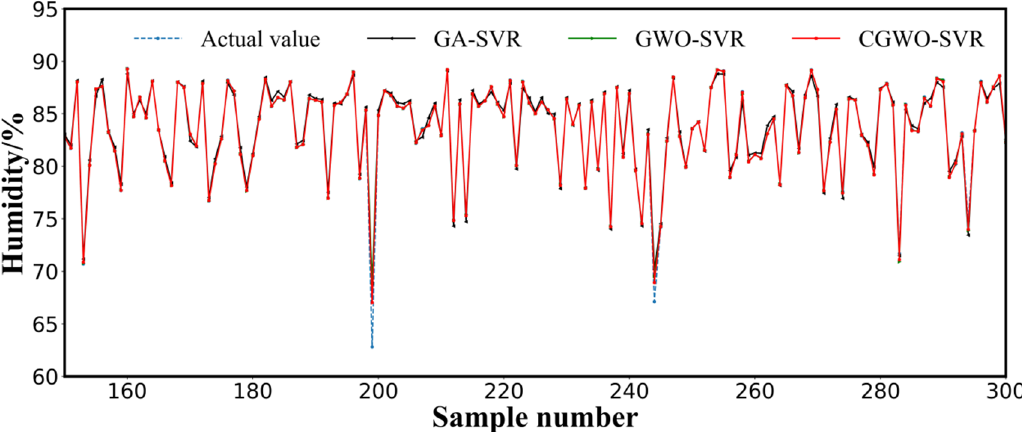
Figure 6. Measured versus computed humidity of GA–SVR, GWO–SVR, and CGW–SVR (part of validation